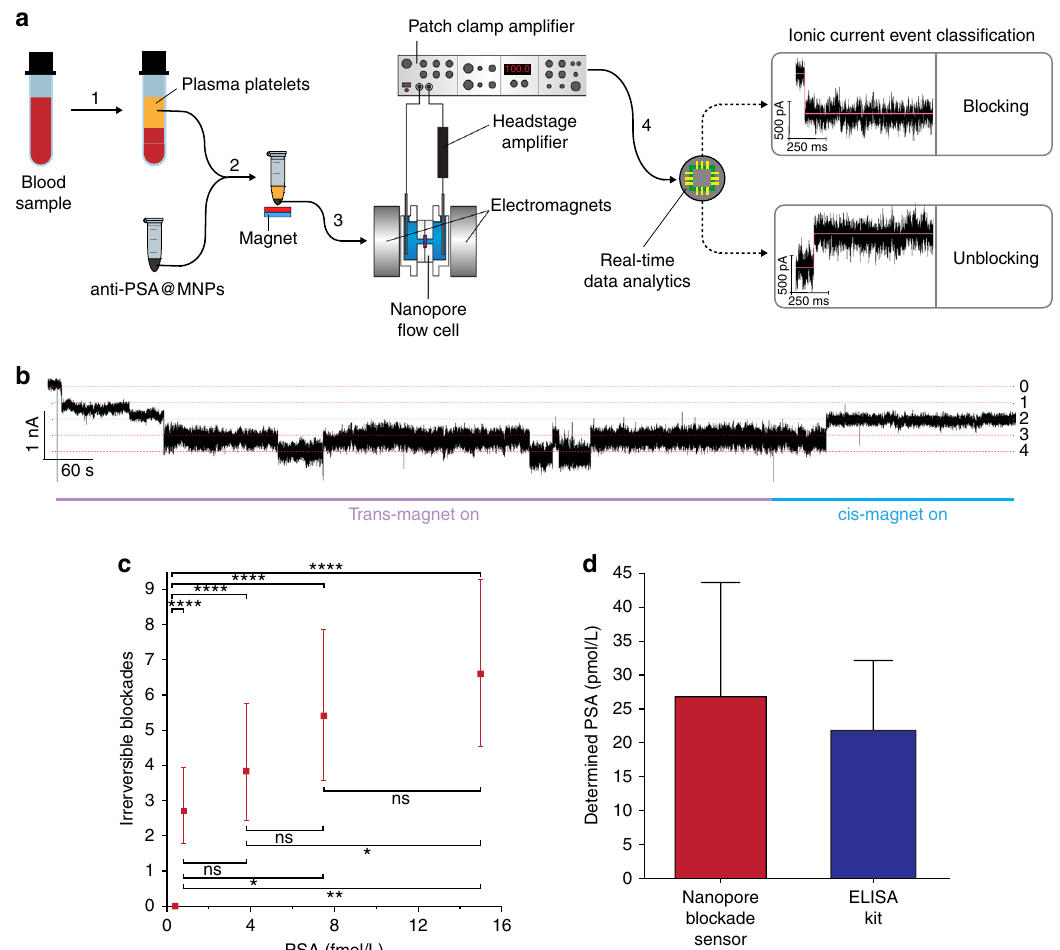
Fig. 5 PSA detection from blood sample. a Flow chart illustrates steps for detecting PSA in blood sample: (1) Plasma platelets were separated from blood with centrifugation. (2) The plasma platelet layer was extracted and mixed with (anti-PSA)-MNPs. The (anti-PSA)-MNPs were magnetically separated and washed with PBS. (3) The (anti-PSA)-MNPs were added into cis-chamber of a fl ow cell. A potential difference was applied between both sides of the nanopore and a magnetic fi eld was applied from trans-side of fl ow cell to initialise detection process. (4) Ionic current measured by patch clamp ampli fi er was analysed by an event classi fi er where three distinct event types — translocation, blocking and unblocking are detected and classi fi ed as they occur. This enables tracking of the number of blocking and unblocking events that occurred over the course of analysis. For application here in quantitative analysis, SiN membranes have been thinned down to about 80 nm. b Ionic current trace from one experiment that employed (anti-PSA)-MNPs to capture PSA from whole blood and transferred to the 3 × 3 array nanopore blockade sensor. The trace shows four blockade events but upon switching on the cis-magnet it transpires two of these blockade events are non-speci fi c. c Irreversible blockades observed versus PSA concentrations. Blockade events were counted after 4 cycles of switching on trans-magnet for 10 min, and subsequently cis-magnet for 5 min to maximise probability of blockade events at extremely low concentrations. Mean value of irreversible blockades and 95% exact con fi dence intervals were obtained from a total of 31 measurements ( n = 5, 10, 6, 5 and 5 from lower to higher concentrations; one measurement per chip). Of these measurements, 23 chips were employed and 8 of them were regenerated. The exact method was used to compute 95% con fi dence intervals for Poisson means. The difference between any two determined Poisson means was tested by a two-tailed z-test of square root transform version; ns = not signi fi cant, * p ≤ 0.05, ** p ≤ 0.01, *** p ≤ 0.001 and **** p ≤ 0.0001. d Comparison of PSA level from whole blood using nanopore blockade sensor versus an ELISA kit. Error bars represent uncertainty of determined PSA concentration at 95% con fi dence by nanopore sensing ( n = 6) and ELISA kit ( n = 12),